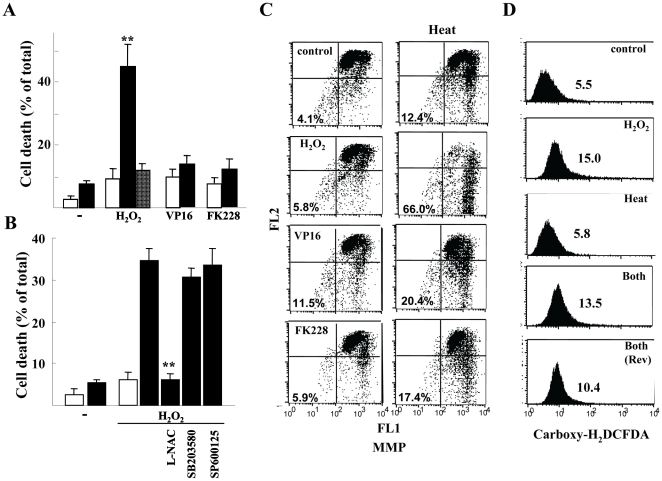
Cell death in H2O2 and/or heat-treated T98G cells.
A) Trypan blue exclusion assay. Cell death 24 h after heat exposure (44°c for 20 min) (closed bars) with the indicated pretreatments (0.25 mM H2O2, 25 µg/ml VP16 or 50 nM FK228). Alternatively, cells were exposed to heat and thereafter treated with 0.25 mM H2O2 as reverse treatment (gray bar) or unexposed to heat (open bars). **, P<0.01 compared with cells treated alone as indicated. B) Cell death was evaluated 20 h after heat exposure. Cells were pretreated with 5 mM L-NAC, 10mM SB203580 or 10 mM SP600125 for 2 h, thereafter treated with 0.25 mM H2O2, and unexposed (open) or exposed (closed bars) to 44°c for 20 min. **, P<0.01 compared with heat/H2O2-treated cells. In A and B, error bars indicate the mean ± S.D. of data from three separate experiments. C) Disruption of Δψm. Cells were cultured for 20 h after the indicated treatments as described in A), and then intracellular DePsipher fluorescence was detected. Numbers indicate % of cells showing loss of Δψm. D) ROS generation. Carboxy-H2DCFDA fluorescent signals 2 h after treatment with 0.25 mM H2O2 (H2O2), heat exposure (44°c for 20 min; Heat) or both (Both). Both (Rev) indicates reverse treatment (heat exposure before H2O2 treatment). In representative histograms, numbers indicate mean fluorescence intensity.